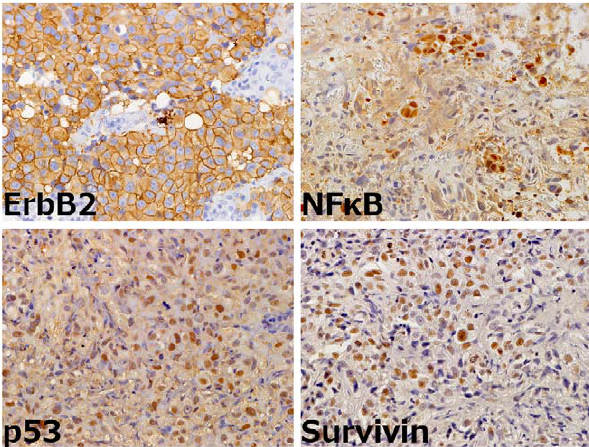
Figure 1. Representative microphotographs of MIBC positive for erbB2 (upper left), NF k B (upper right), p53 (lower left), and survivin (lower right). Reduced from 6 400.